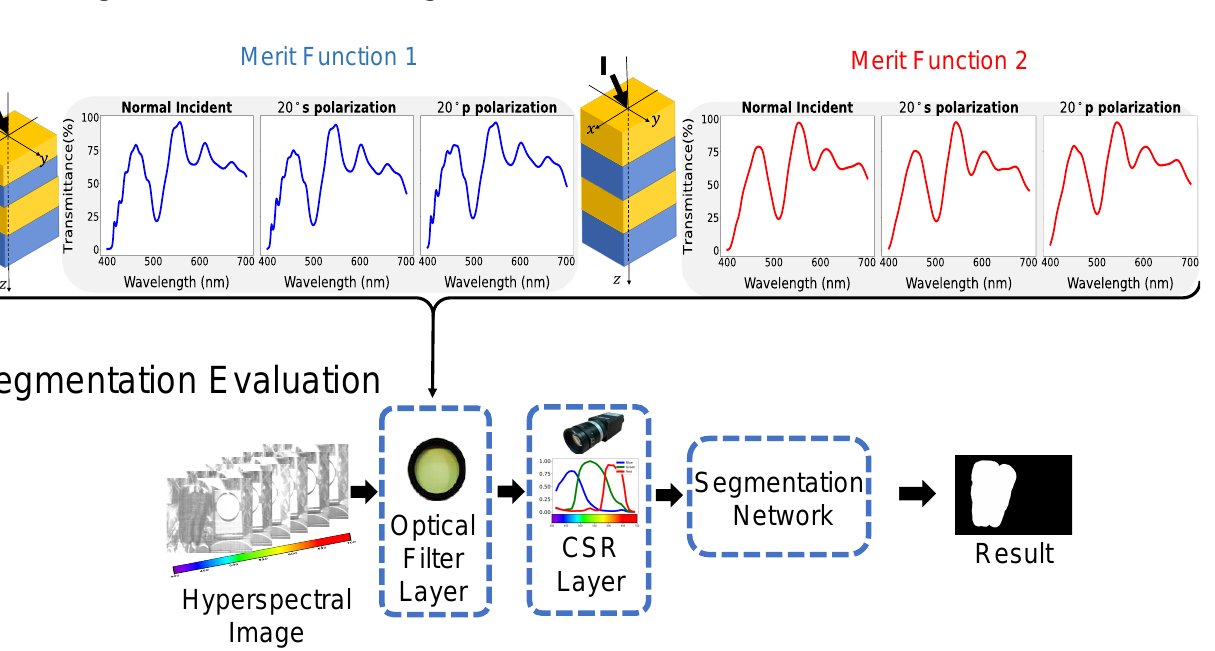
Figure 6. The illustration of the evaluation method for our Green Pepper Filter, merit function 1 optimization result, merit function 2 optimization result at 0 ◦ and 20 ◦ . In the whole pipeline, the weights of the neural network and camera layer is fixed. We replace different transmittance curve of the different design for the weight of optical filter layer and evaluate the segmentation performance on the green pepper hyperspectral